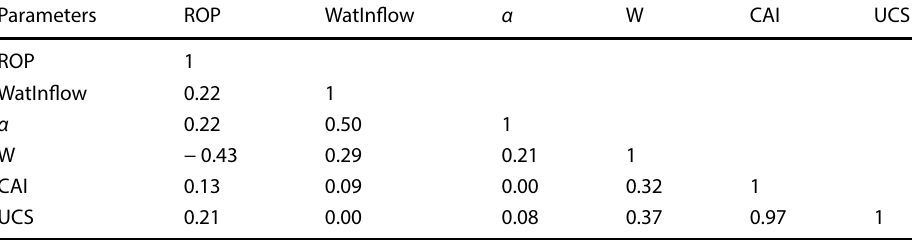
Table 3 Coefficient of correlations ( R ) obtained from the simple regression analyses